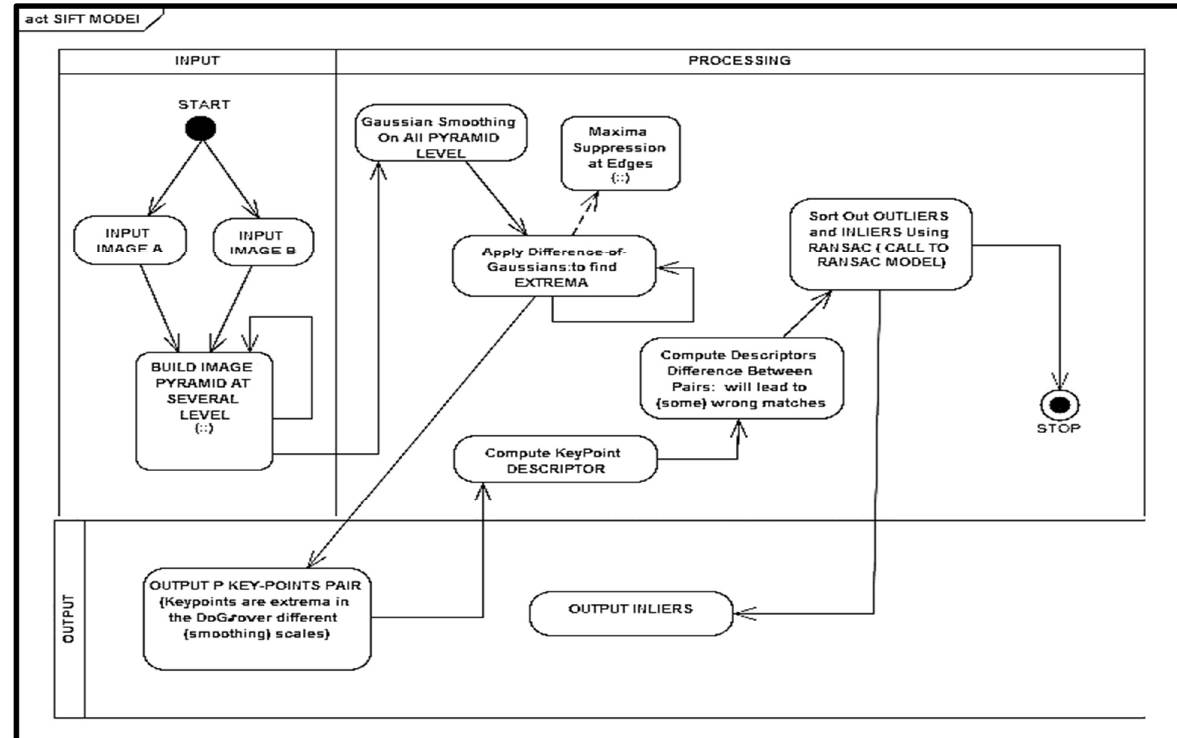
Figure 2: Activity diagram of Scale Invariant Feature Transform (SIFT)